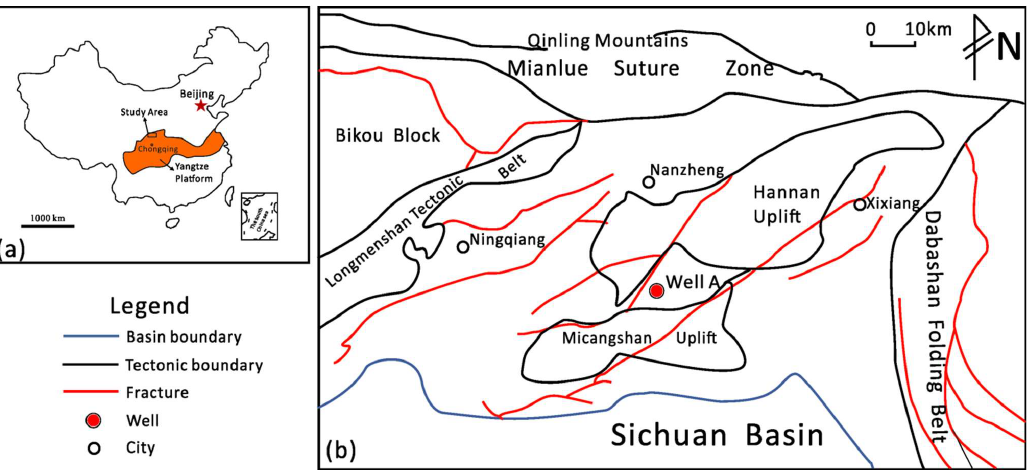
Figure 1. Location of the study area in the Yangtze Platform ( a ) and the geological map of the study area in the northern part of the Yangtze Platform and well location ( b ). The geological map of the study area is modified from Chen et al., (2019) [21].